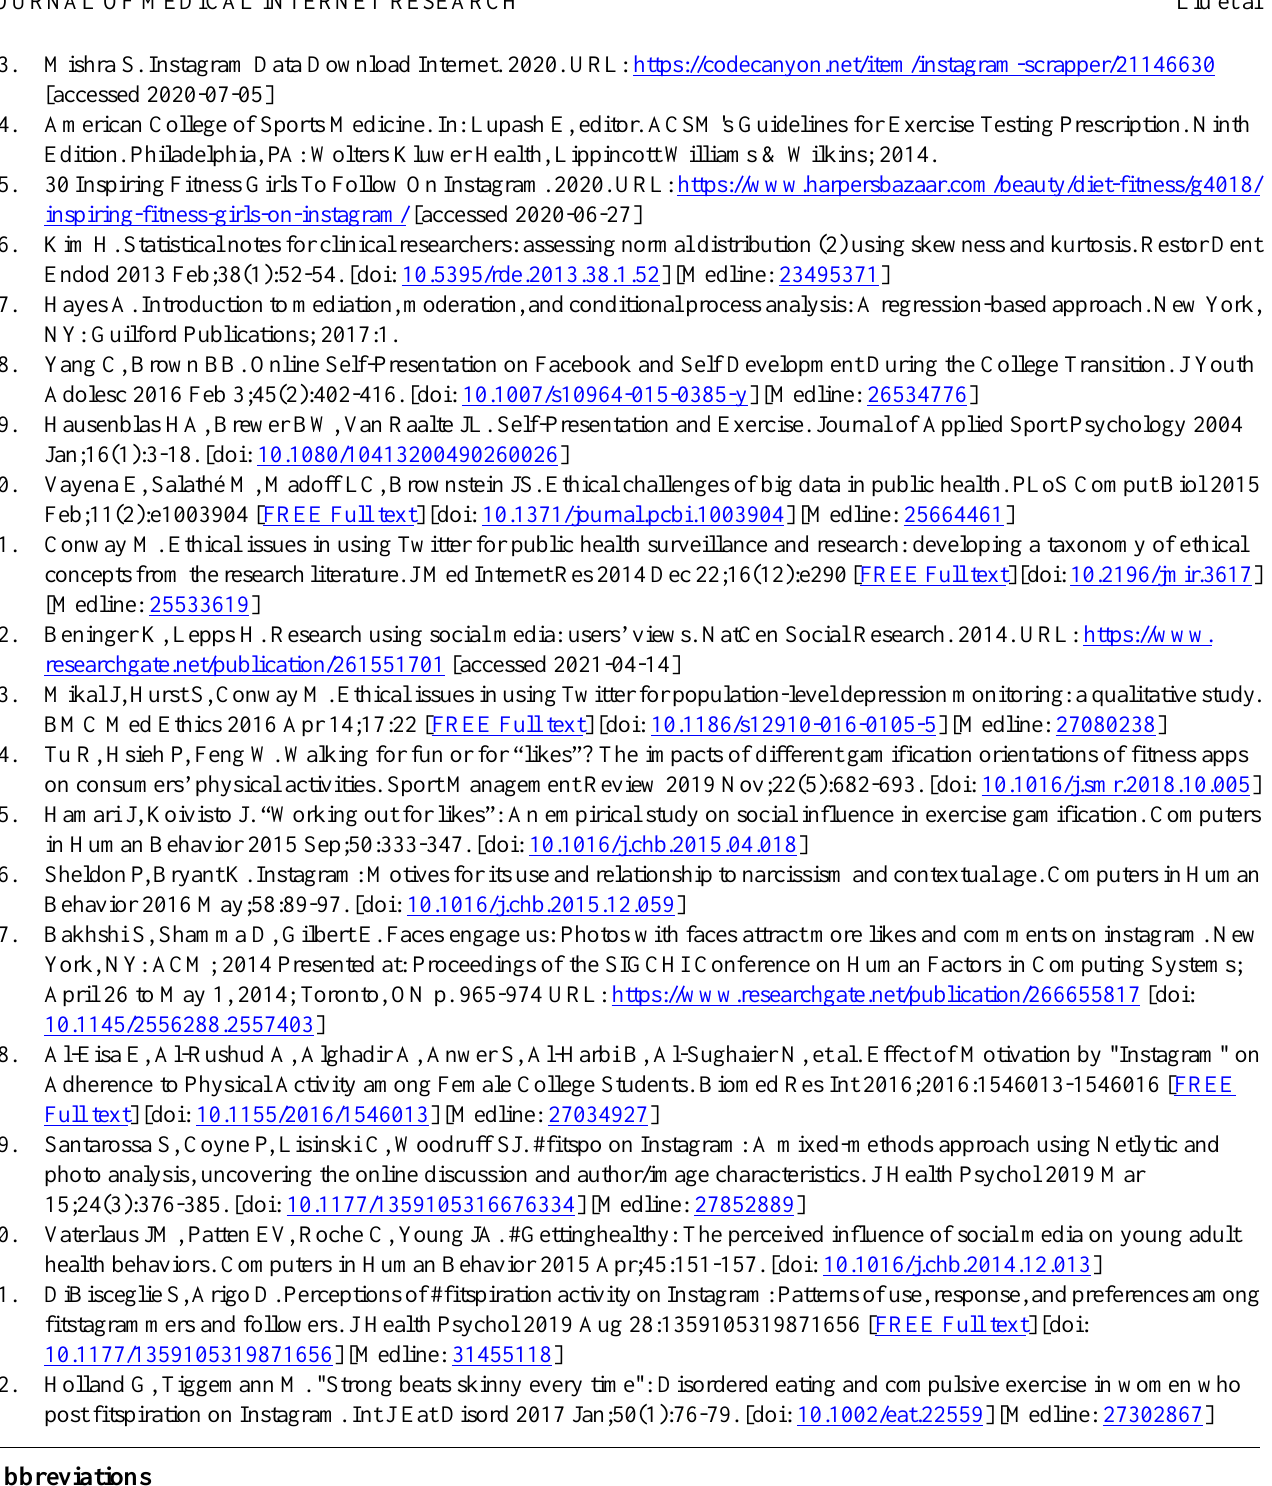
Abbreviations MET: metabolic equivalent of task PA: physical activity RPAQ: Recent Physical Activity